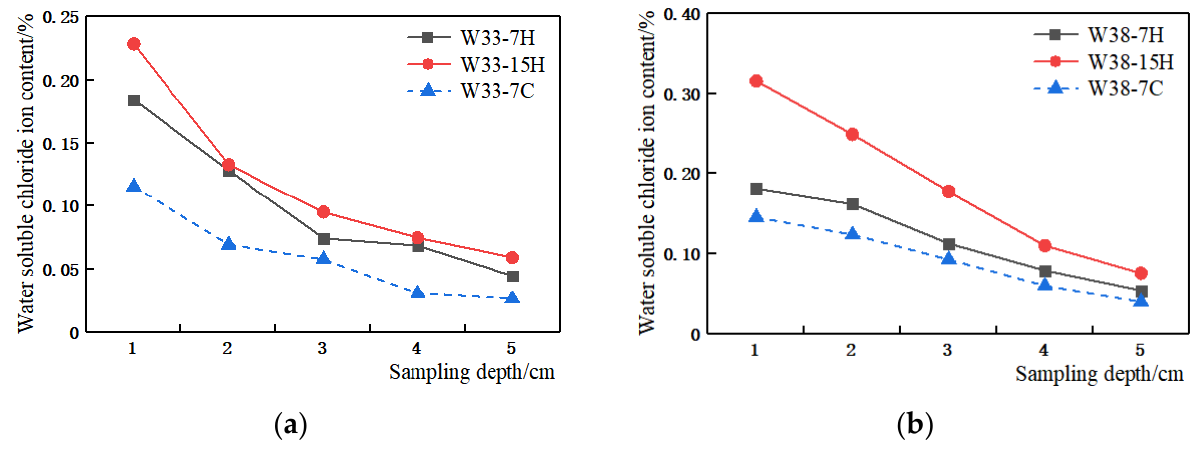
Figure 6. Comparison of ultimate bearing capacity in two models: ( a ) W/C ratio of 0.33 under tensile stress; ( b ) W/C ratio of 0.38 under tensile stress. Table 3. Cl − content in concrete with different ratios (24